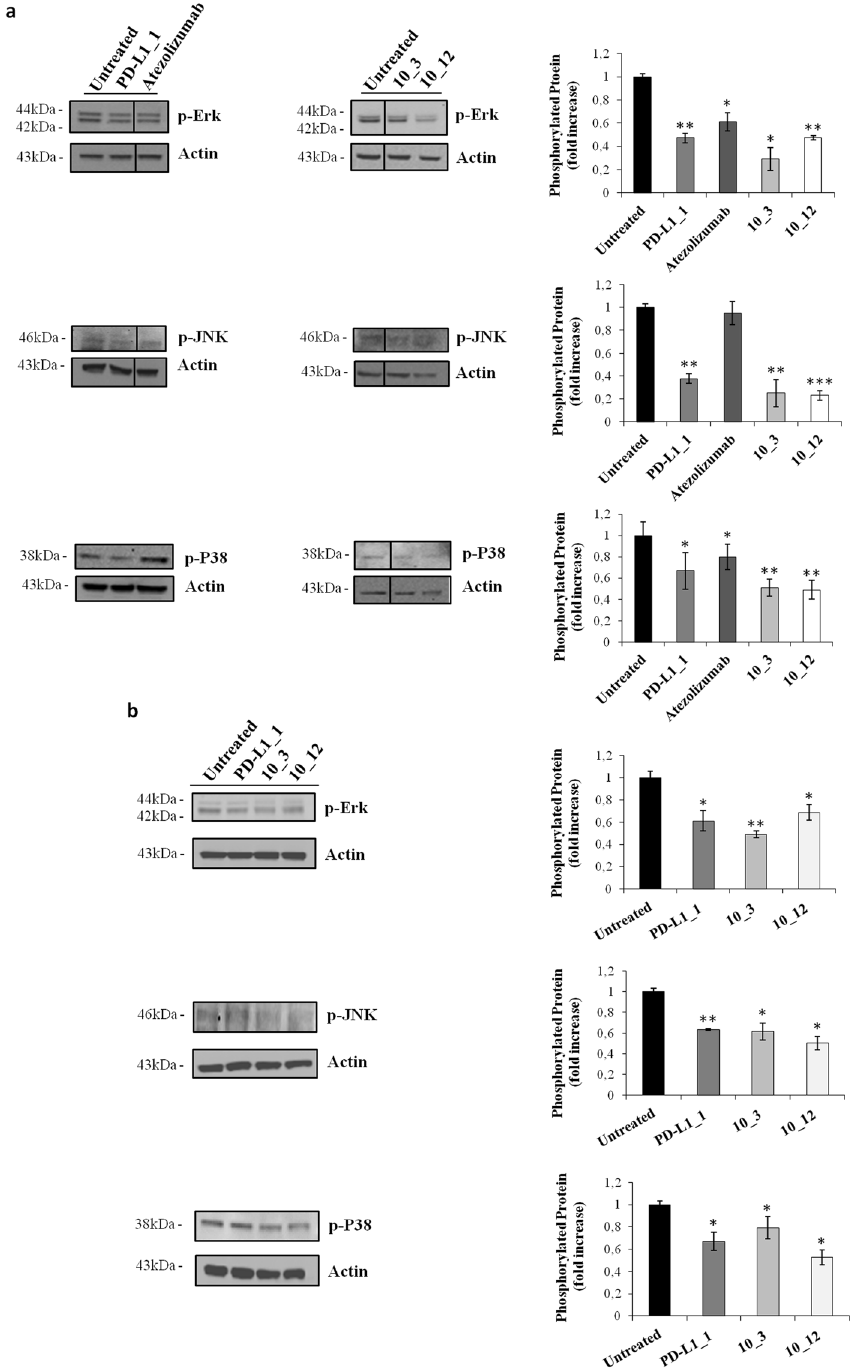
Figure 5. Effects of PD-L1_1 on the pathways associated with PD-L1 in tumor cells. Western blotting analyses with the specific antibodies for the indicated proteins of extracts from SK-BR-3 ( a ) and MDA-MB-231 ( b ) tumor cells treated in the absence or in the presence of PD-L1_1 or its high affinity variants. Atezolizumab was used as a positive control. A line has been inserted to indicate distant lanes of the same gel (see Supplementary dataset). Protein levels are also expressed as fold increase with respect to those observed in untreated cells and normalized to actin. Error bars depicted means ± SD. P values for the indicated mAbs relative to untreated cells, are: *** P ≤ 0.001; ** P < 0.01; * P <